Question: State the chart type depicted above.
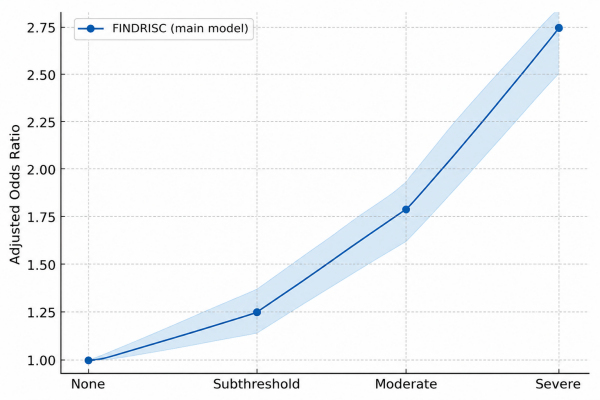
Answer: line